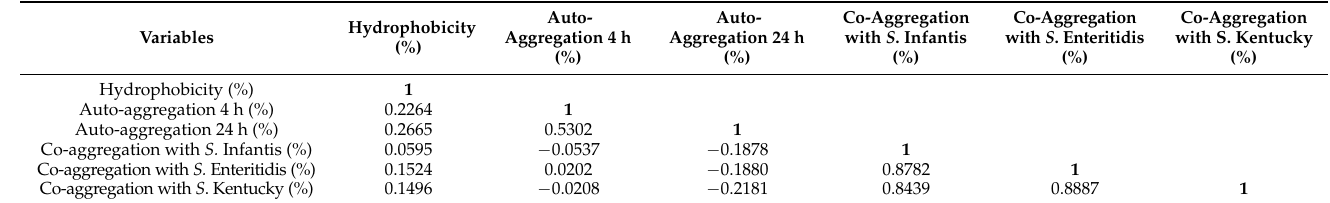
Table 2. Correlation of Pearson coefficients between hydrophobicity, auto-aggregation and co- aggregation of the 48 lactobacilli isolates. The index of Pearson was used to evaluate the correlation between the six assays, hydrophobicity, auto-aggregation and co-aggregation between the lactobacilli strains and S. Enteritidis, S. Infantis and S. Kentucky